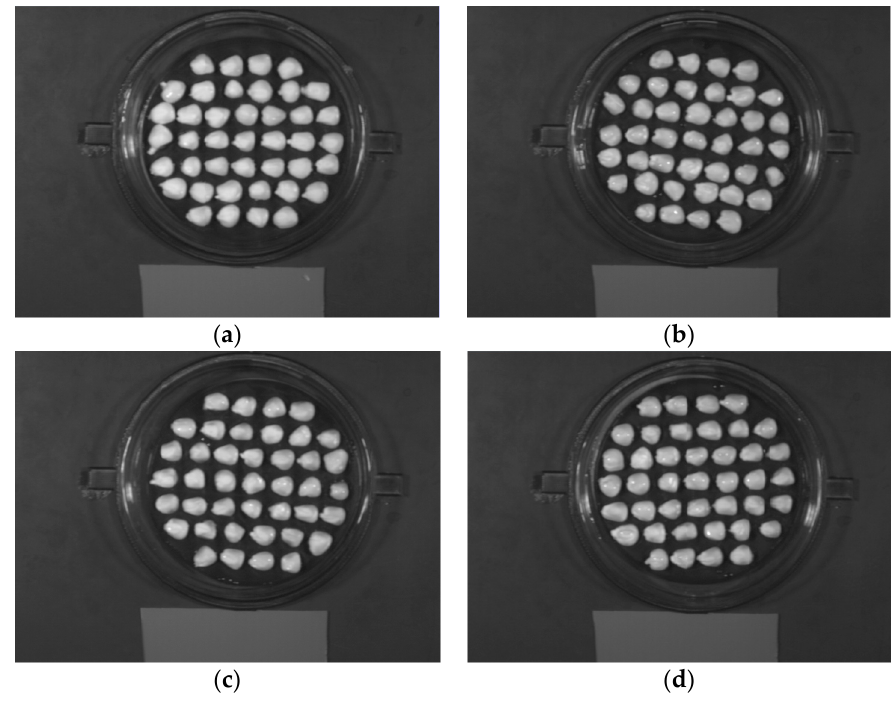
Figure 3. The example hyperspectral images of ( a ) A; ( b ) B; ( c ) C; ( d )